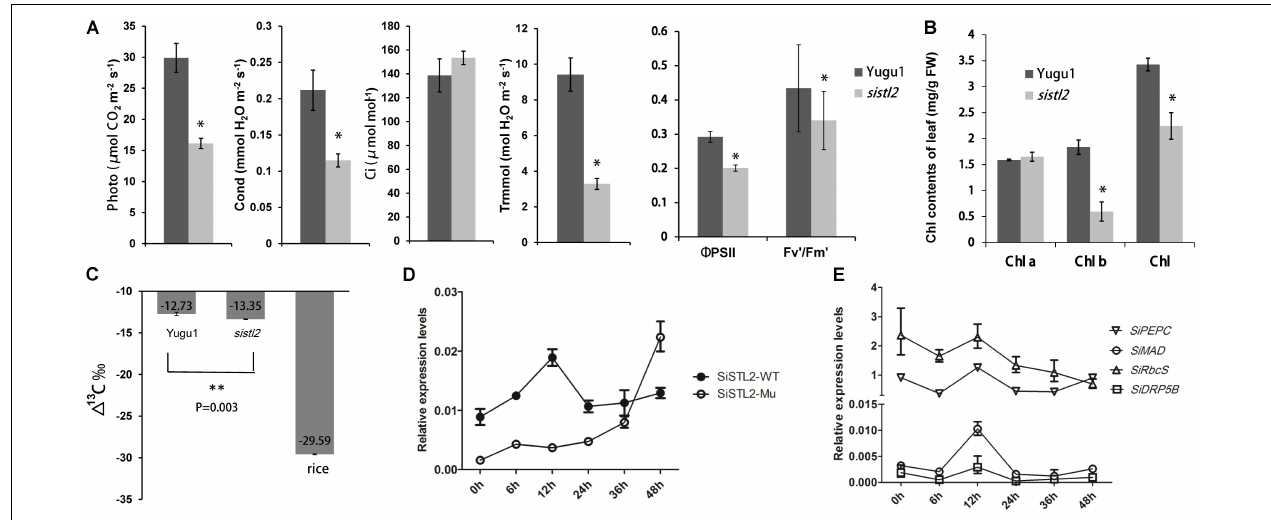
FIGURE 9 | (A) Photosynthetic parameters in WT and sistl2 . Photo, net photosynthetic rate. Cond, stomata conductance. Ci, intercellular CO 2 concentration. Trmmol, transpiration rate. The means and standard deviations were obtained from five independent leaf samples. Statistical analysis was performed with the t -test. ∗ P = 0.05. (B) The chlorophyll contents of Yugu1 and sistl2. The means and standard deviations were obtained from five independent leaf samples. Statistical analysis is performed with the t -test. ∗ P = 0.05. (C) 13 C contents in leaves of WT, sistl2 , and rice. ∗∗ P = 0.01. (D) The expression patterns of SiSTL2 gene in Yugu1 and the mutant under low CO 2 treatment. (E) Expression patterns of the C 4 photosynthesis genes in low CO 2 conditions. PEPC, phosphoenolpyruvate carboxylase; MAD, malate dehydrogenase; RbcS, rubisco small submit; DRP5B, a dynamin-related family protein involved in chloroplast division and development (Pyke and Leech, 1994). The means and standard deviations were obtained from three independent samples.